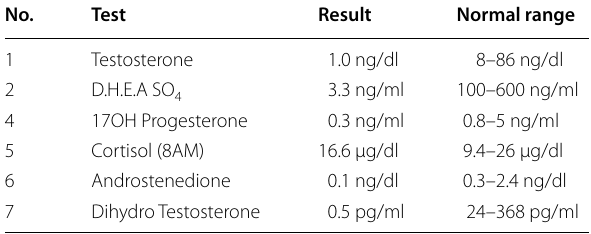
Table 1 Laboratory results of the patient